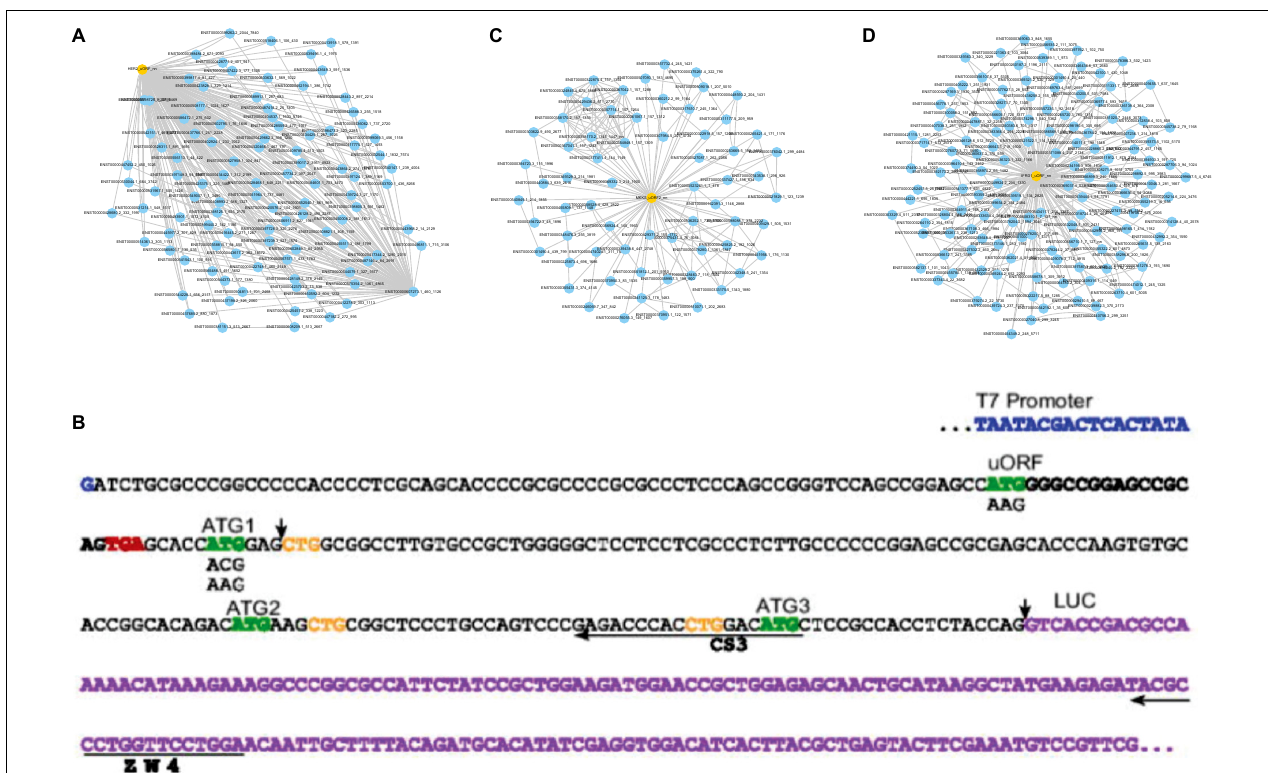
FIGURE 4 | The detailed sub-networks to give functions. (A) Sub network to predict HER2_uORF functions. (B) The 5 (cid:48) leader regions of HER2 sequence annotated by Sachs team (Spevak et al., 2006). FSPP-detected black bold sequence produced a 6-length functional peptide. (C) Sub-network to predict MKKS_uORF functions. (D) Sub-network to predict IFRD1_uORF